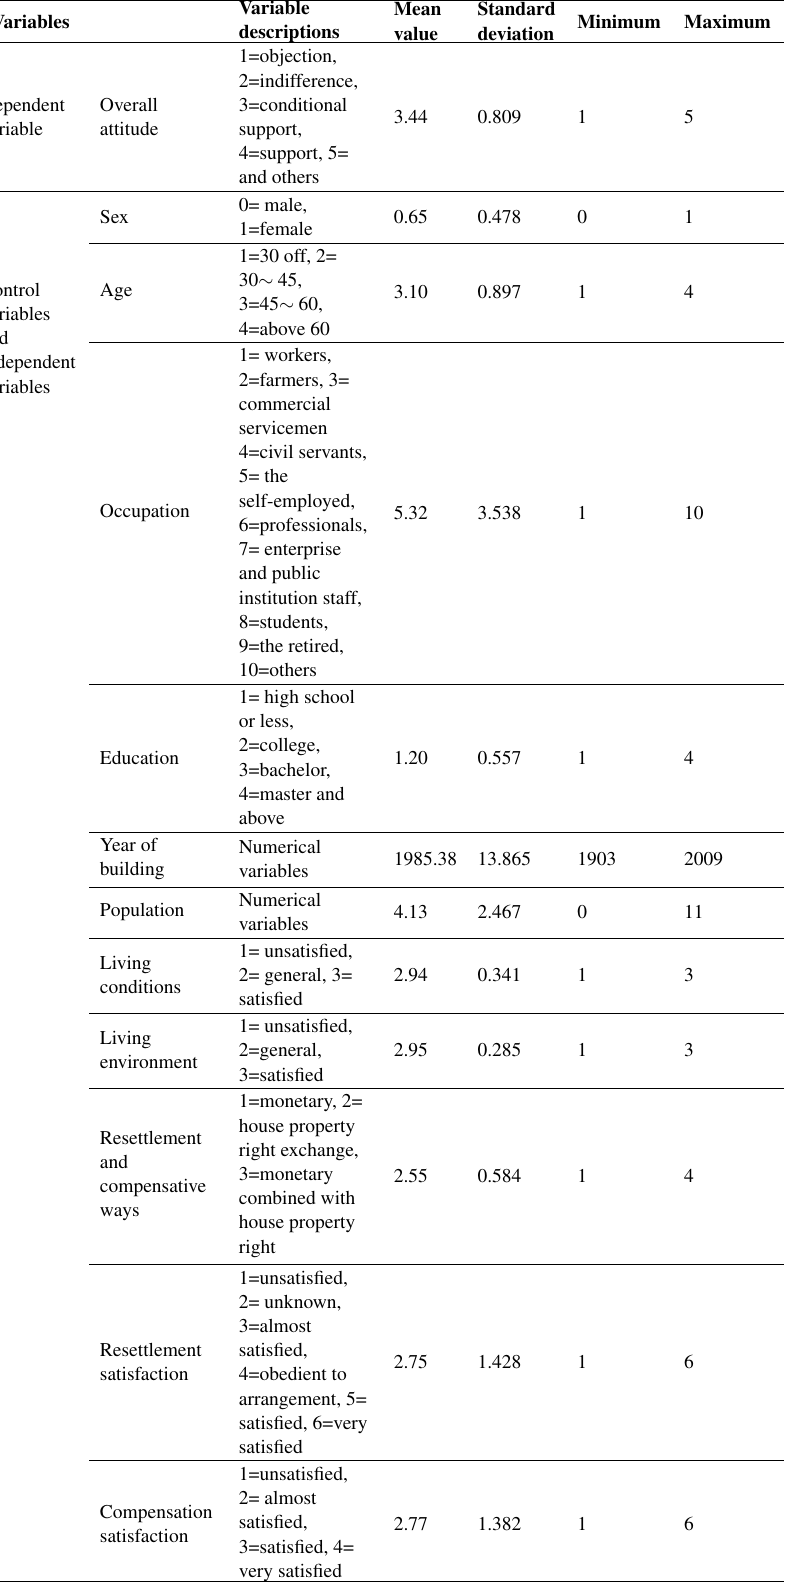
Table 2 Statistical analysis on variable descriptions of stakeholders ( n = 217)